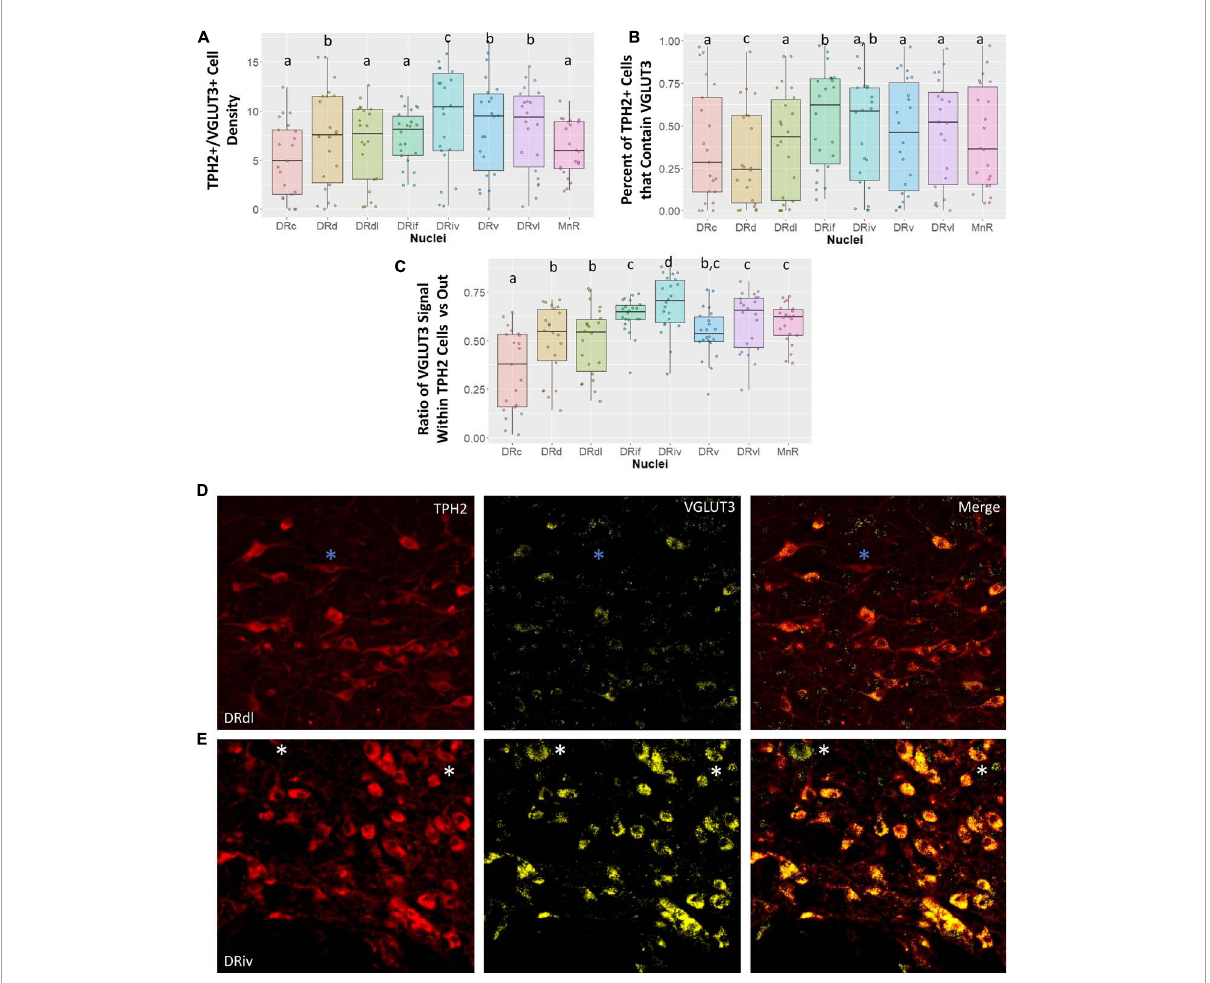
FIGURE3 Vesicular glutamate transporter 3 (VGLUT3) cell measurements across subnuclei within the greater raphe nuclei. Data are expressed as box plots with boxes indicating the 1st–3rd quartile range and the median expressed as the horizontal bold line. Nuclei that share letters (e.g., “a”) are not significantly different from each other, different letters indicate significant differences between subnuclei at p < 0.05. Bonferroni corrections were made when making multiple comparisons across all different subnuclei included. In instances denoted with multiple letters (e.g., “a, b”) these groups are not significantly different from any groups that are also denoted with the same letter. (A) Cell density of tryptophan hydroxylase 2 (TPH2)/VGLUT3 dual positive cells in each subnuclei region. Dual positive cells were defined as TPH2+ cells that contained 20 or more pixels of VGLUT3 signal. (B) Percent of all TPH2+ cells that also have VGLUT3 signal. (C) Ratio of signal that is located either inside or outside of a TPH2+ cell. A ratio of 0.5 indicates VGLUT3 signal is equally likely as not to occur within a TPH2+ cell. Ratios above 0.5 indicate a high likelihood VGLUT3 signal will be located inside a TPH2+ cell. (D,E) Representative images of TPH2 and VGLUT3 signal localization. (E) Typical VGLUT3 signal in the DRdl. Blue asterisks indicate TPH2+ cells with a lack of VGLUT3 signal present. Example of intense VGLUT3 signal found in the DRiv. White asterisks indicate VGLUT3+ non-TPH2 cells. These cells additionally serve to demonstrate that although TPH2 signal and VGLUT3 signal are correlated, this is not the result of “bleed-through” between channels. DRd, dorsal nucleus of the dorsal raphe; DRdl, dorsolateral nucleus of the dorsal raphe; DRv, ventral nucleus of the dorsal raphe; DRvl, ventrolateral nucleus of the dorsal raphe; DRiv, fourth nerve nucleus of the dorsal raphe; DRif, interfascicular nucleus of the dorsal raphe subnucleus; MnR, median raphe